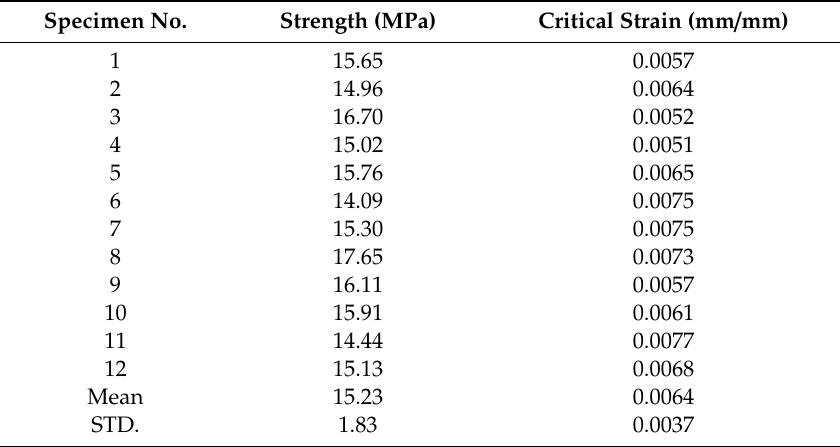
Table 6. Strengths of CA specimens.